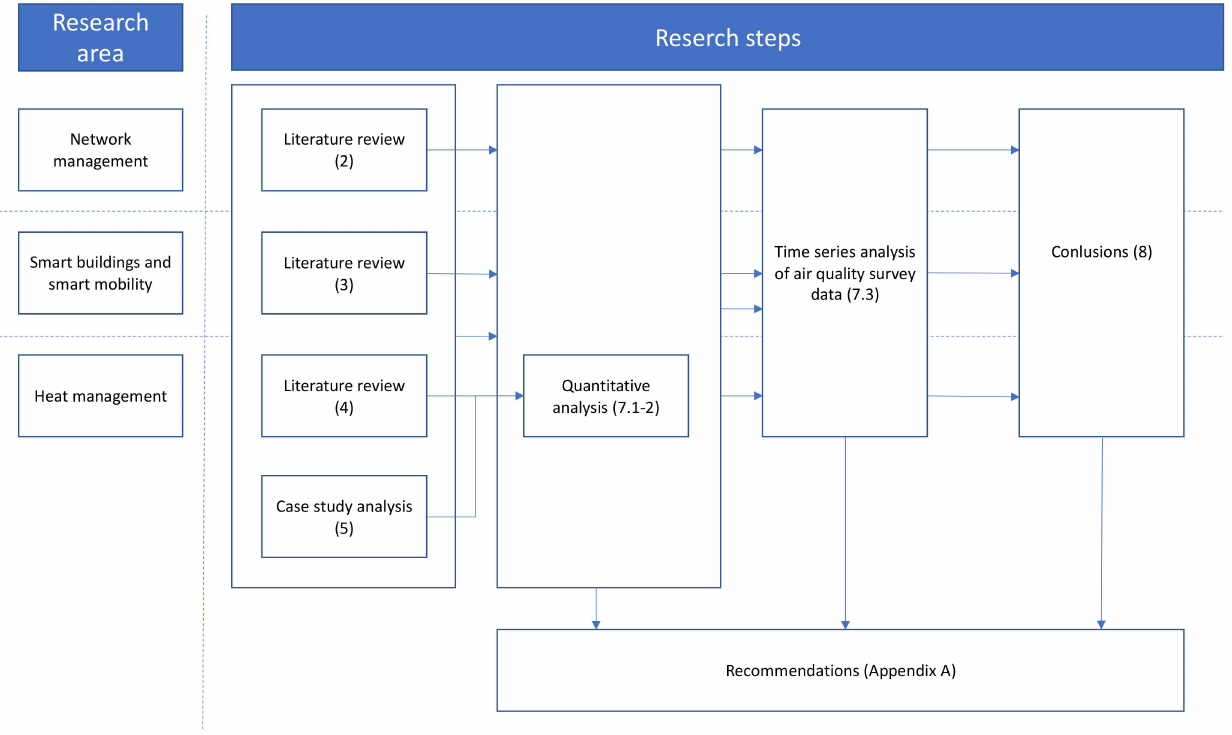
Figure 2. Research